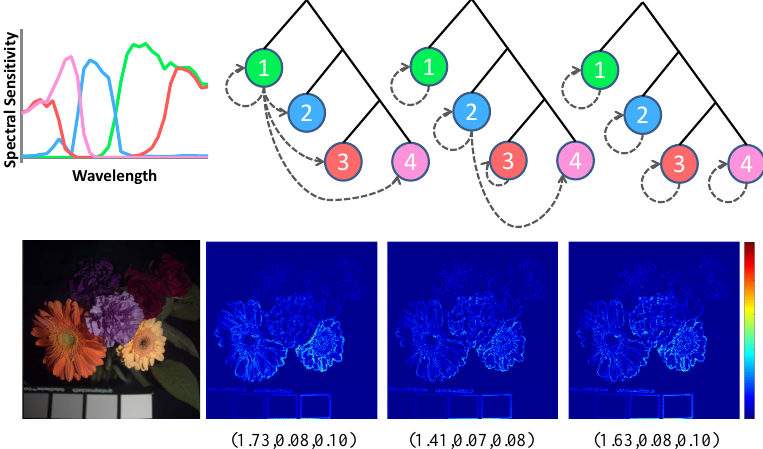
Figure 5. Reconstruction spectral errors of a multispectral image, and the reconstruction error statistics (mean, maxinum, standard deviation) of 18 images caused by different demosaicing strategy, the multispectral images are from CAVE dataset. Dashed arrows from channel a to channel b to denote the demosaicing of the subsampled resolution channel b with the guidance of the full resolution channel a (from left to right: “one-to-many channel-dependent demosaicing”; partial channel-dependent demosaicing; “all channel-independent